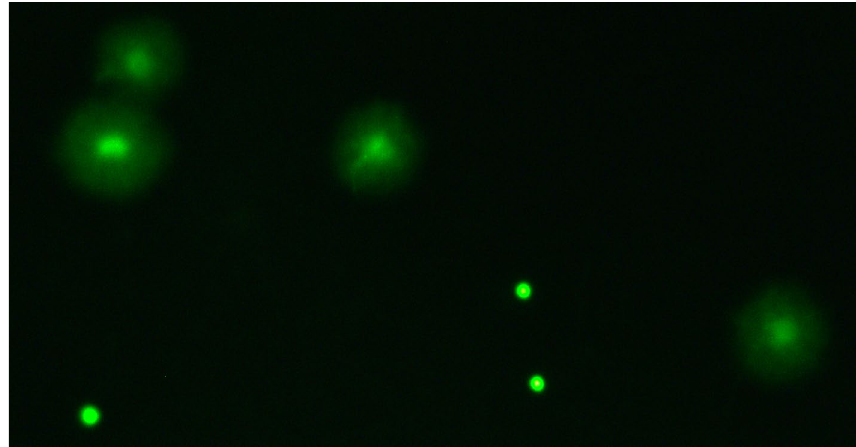
Figure 1. Zebrafish sperm processed with the Halomax-SCD kit. Sperm with fragmented DNA are characterized by the presence of a visible halo, while sperm with intact DNA do not show a halo and retain a compact circular